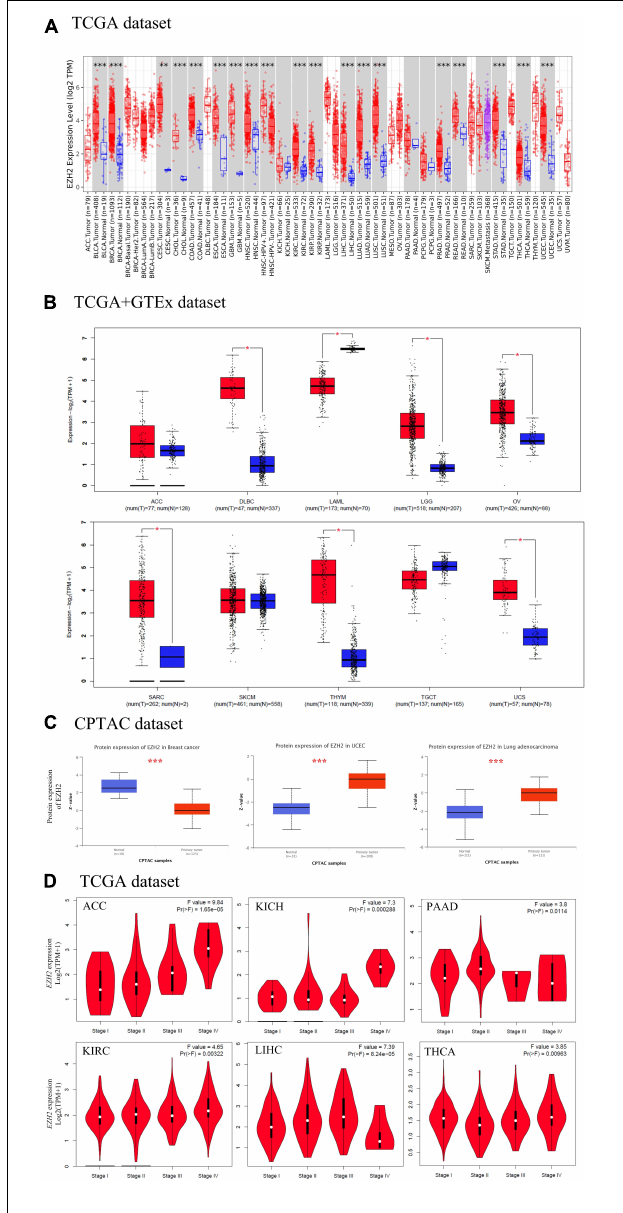
FIGURE 1 | The expression level of EZH2 gene in different tumors. (A) The expression status of the EZH2 gene in different cancers through TIMER2. (B) For the type of ACC, DLBC, LAML, LGG, OV, SARC, SKCM, THYM, TGCT, and UCS in the TCGA project, the corresponding normal tissues of the GTEx database were used as controls. (C) The expression level of EZH2 total protein between normal tissue and primary tissue of breast cancer, UCEC and LUAD were analyzed based on the CPTAC dataset. (D) The correlation between EZH2 expression and the pathological stages of cancers (ACC, KICH, PAAD, KIRC, LIHC, and THCA) were analyzed based on the TCGA data. * P < 0.05; ** P < 0.01; *** P <